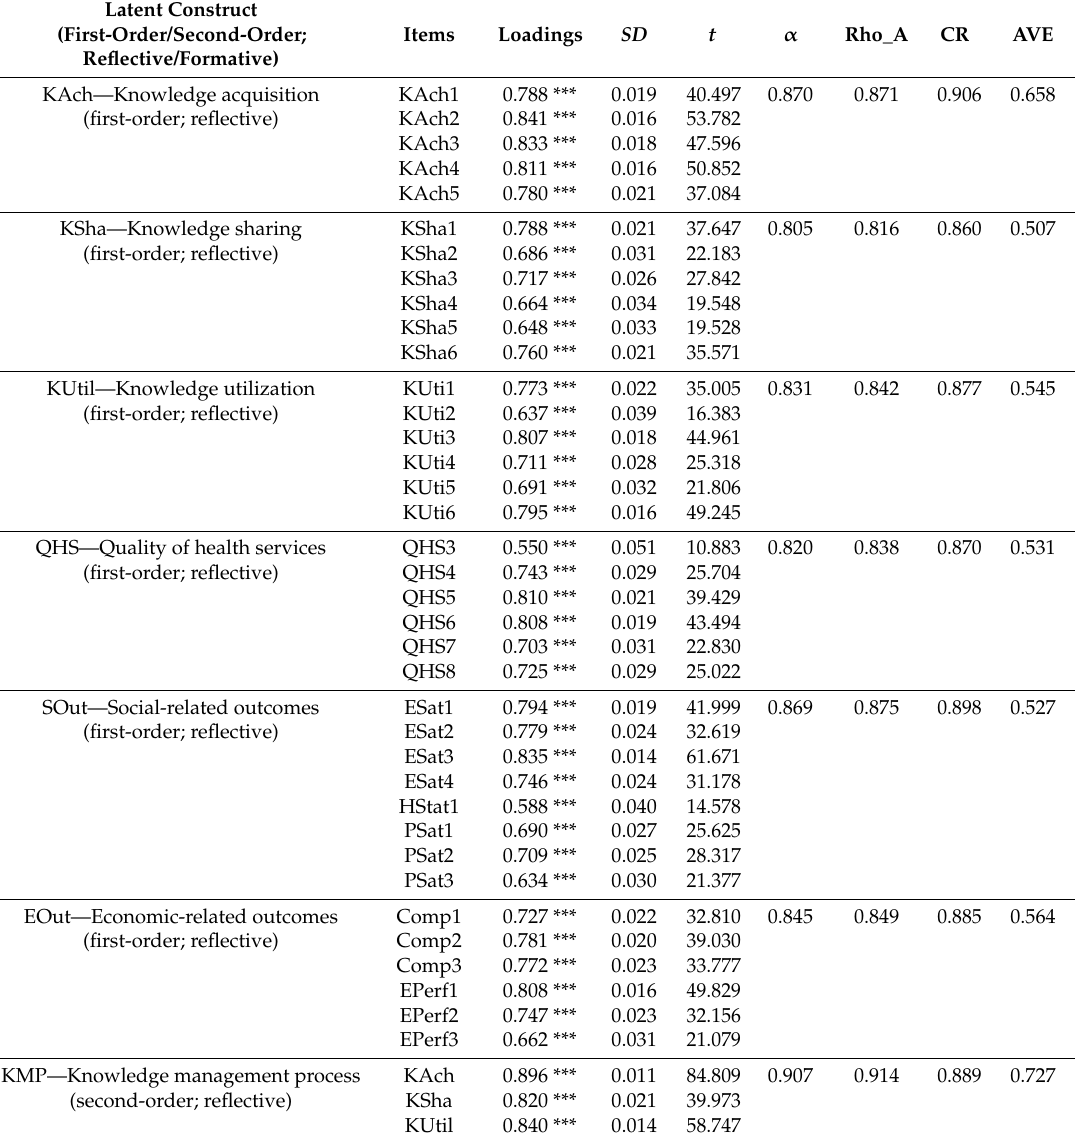
Table 2. Construct reliability and